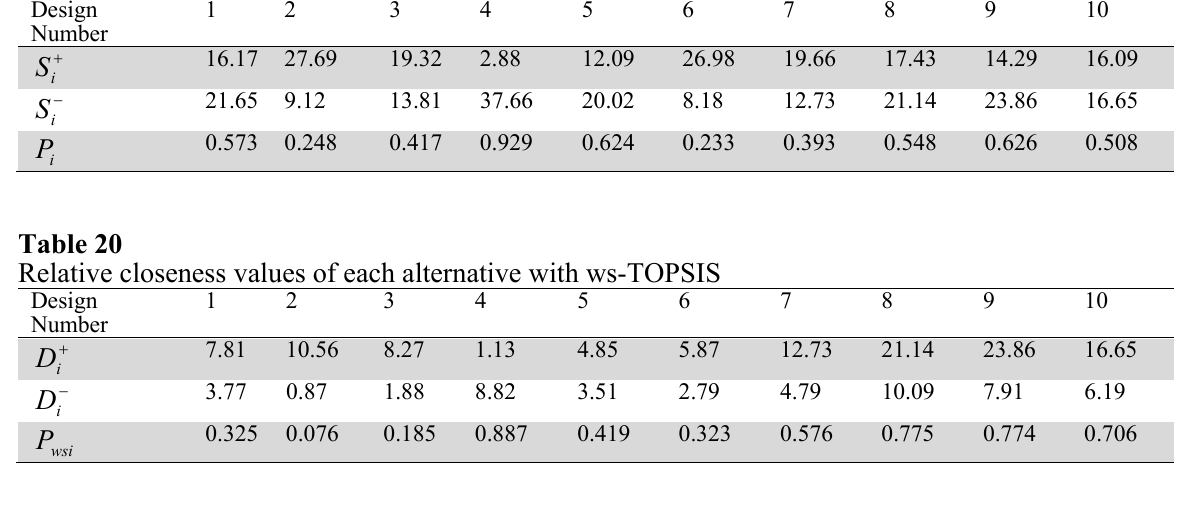
Relative closeness values of each alternative with s-TOPSIS Design Number